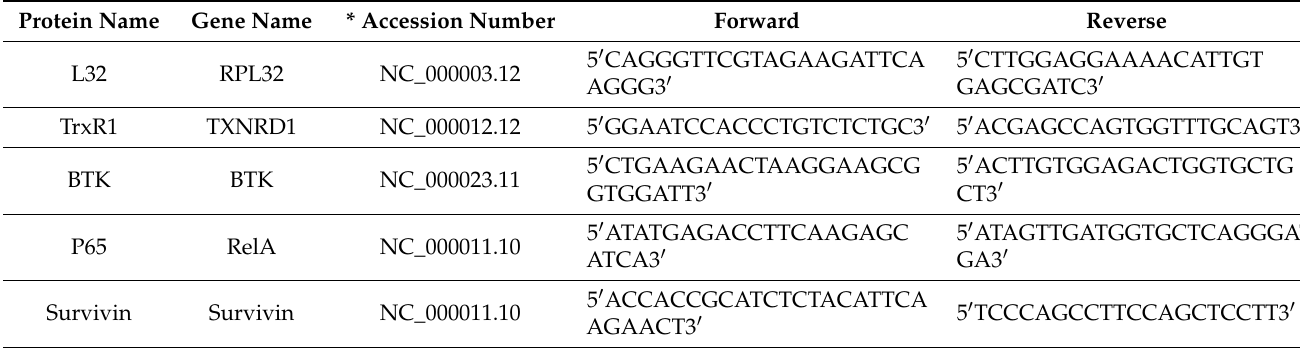
Table 1. List of